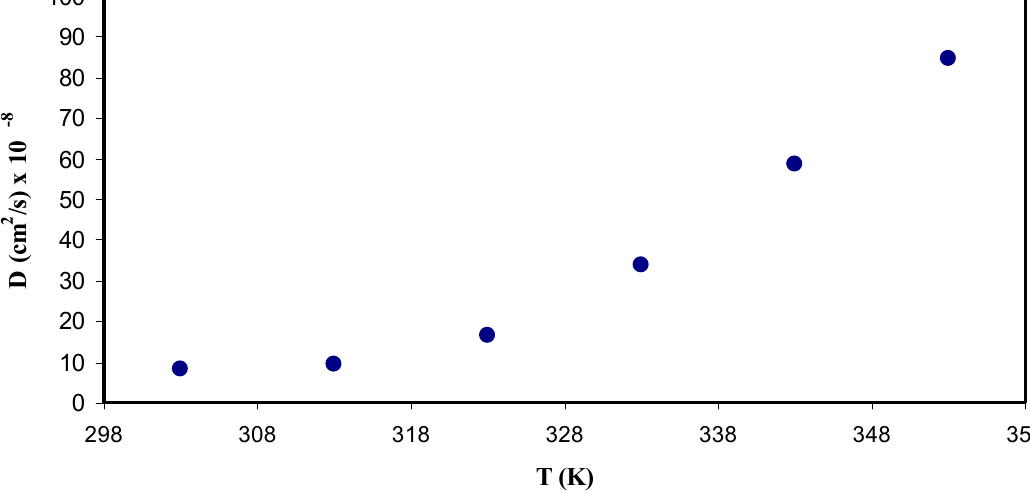
Figure 13. Di ff usion coe ffi cient ( D ) as a function of temperature ( T ). It is obvious that di ff usion coe ffi cient of ions increases nonlinearly with Figure 13. Diffusion coefficient ( D ) as a function of temperature ( T ). It is obvious that diffusion coefficient of ions increases nonlinearly with temperature.